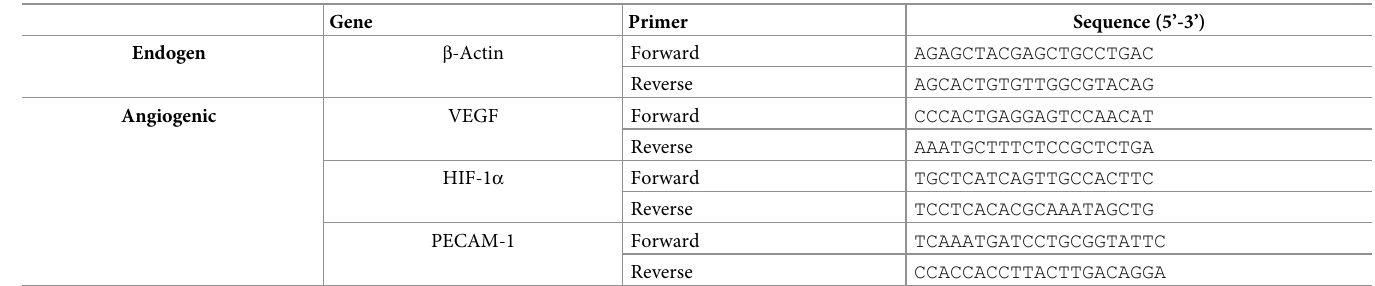
Table 1. List of primers sequences used for cDNA amplification in RT-qPCR.